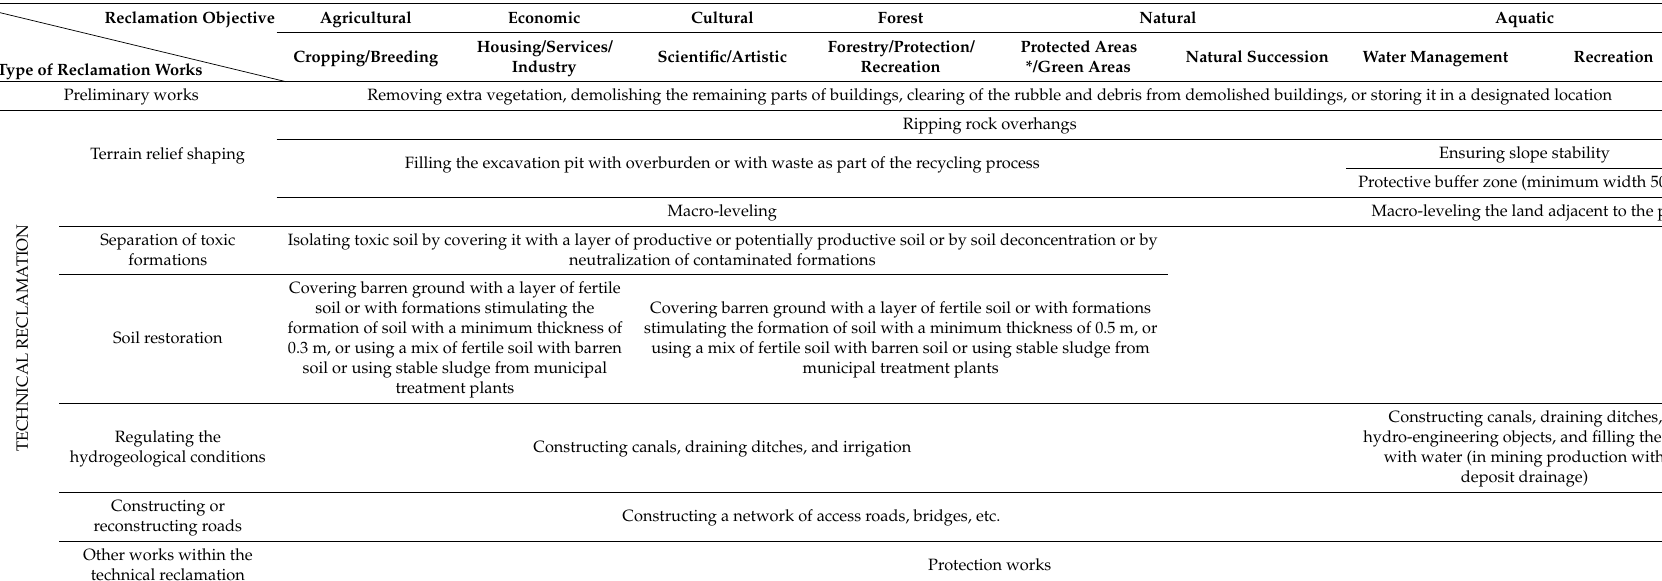
Table 4. The scope of reclamation works of the technical phase for areas after exploitation of compact